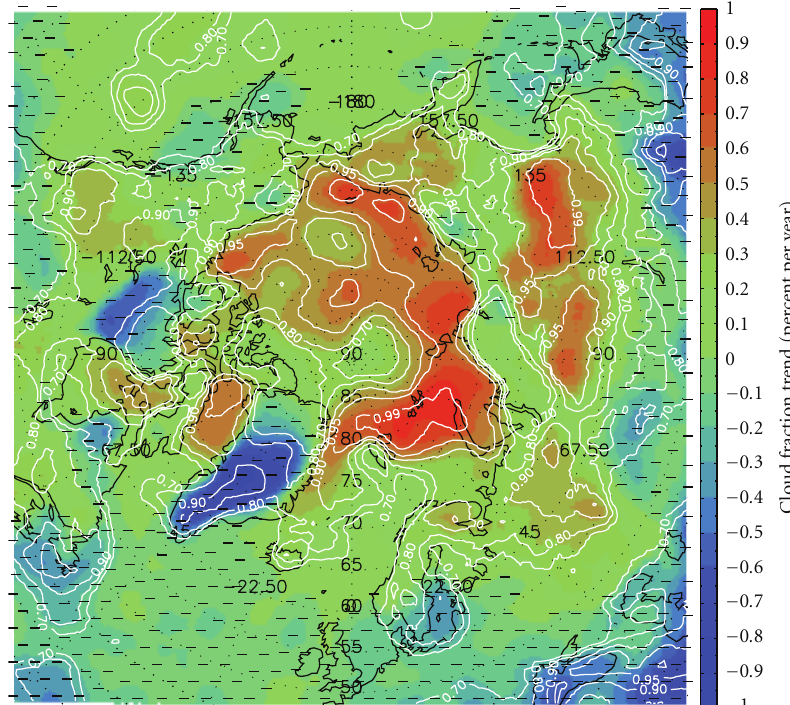
Figure 7: As in Figure 4, but for the cloud fraction in spring (March, April, and May, MAM). Areas with decreasing trends are marked with dashes.